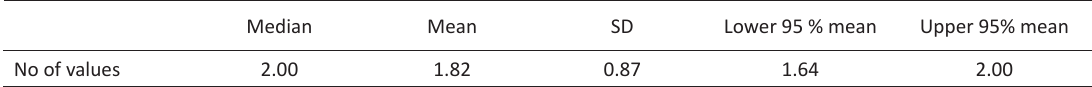
Table 2. Number of values per farmer Median Mean SD Lower 95 % mean Upper 95% mean No of values 2.00